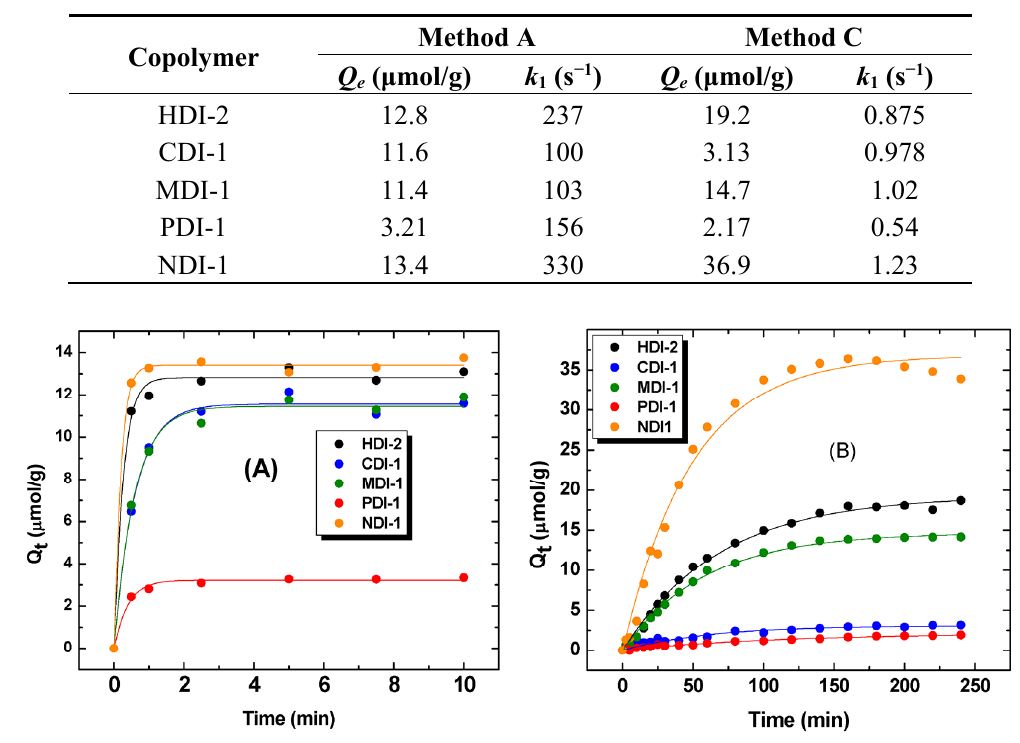
Table 1. Q e and k 1 values obtained from pseudo-first order (PFO) kinetic model using the data obtained in Figure 2.